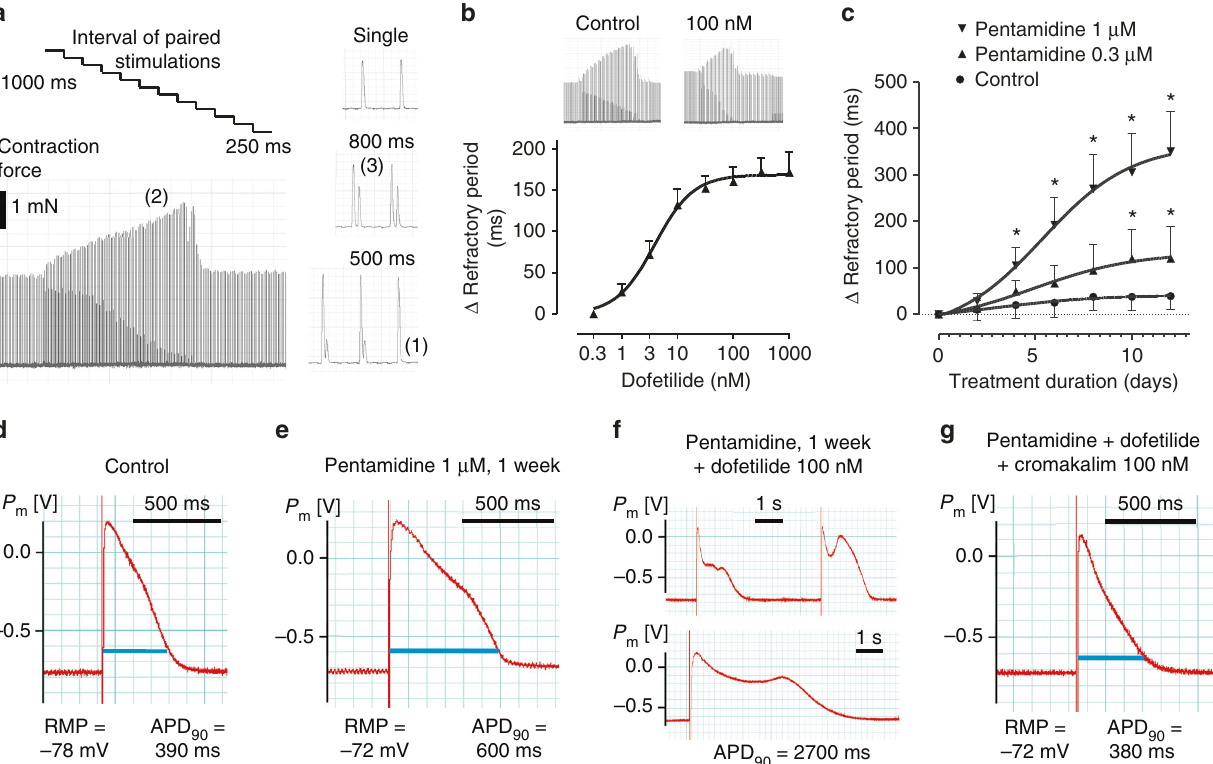
Fig. 5 Assessment of refractory period and effects of hERG-channel blockade. a Stimulation protocol that applied paired stimulation pulses with successively decreasing time-lag. Loss of the subsequent contraction indicated equality with the refractory period (1). Phenomena of post-rest potentiation (2) and attenuation of premature beats (3) were likewise observed. b Dose-dependent increase of refractory period by the hERG-channel blocker dofetilide ( n = 5, mean ± SEM). c Delayed increase of refractory period by the multimodal channel blocker pentamidine (* P <0.05 vs. baseline, two-way ANOVA, n = 5, mean ± SEM). d – g Intracellular recordings of action potentials in tissue slices after 3 weeks biomimetic cultivation either under standard conditions ( d ), or after a 1-week exposure to pentamidine ( e – g ) (representative observations). f , g Slices chronically pretreated with pentamidine were exposed acutely to combinations of the hERG blocker dofetilide and the K ATP -channel activator cromakalim. P m = membrane potential, RMP = resting membrane potential, APD 90 = action potential duration at 90% repolarization. Source data of panels 5b, c are provided as Source Data fi